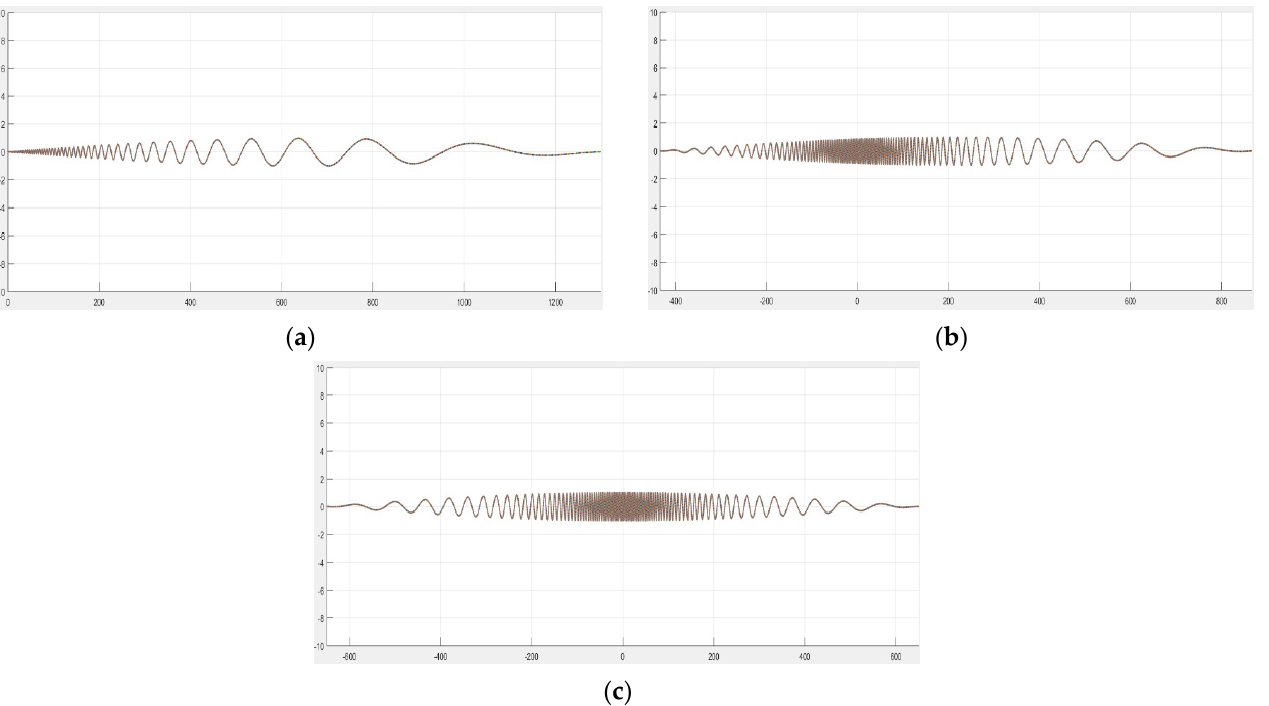
Figure 7. Influence of the laser scanner location on the ripples’ pattern. ( a ) Scanner located underneath the left support; ( b ) Scanner located at one-third from the left support; ( c ) Scanner located at the mid − span.